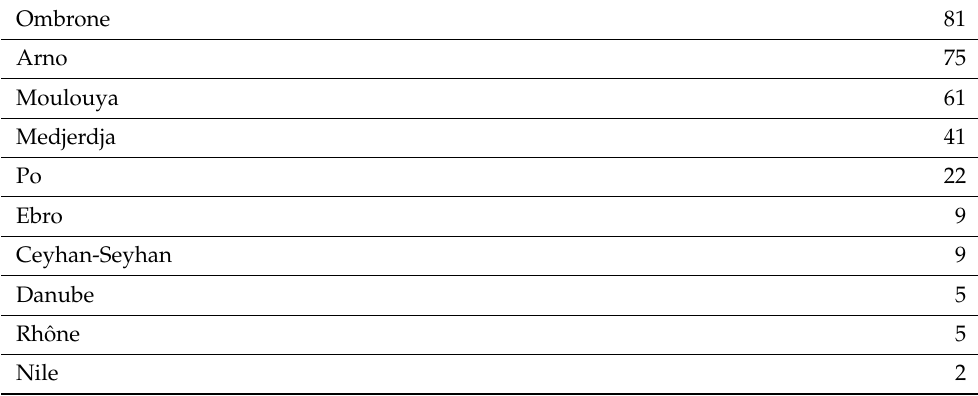
to overall delta GSW